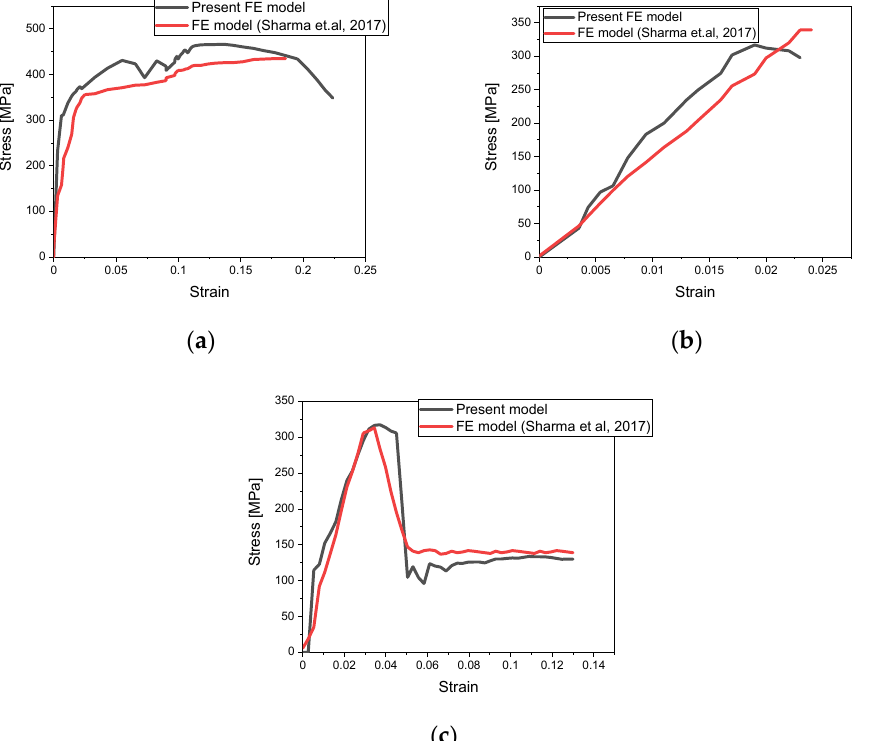
Figure 4. Stress–strain curves of Present FE model and Sharma et al. FE model [20] for ( a ) AL-2024 T3 alloy; ( b ) of [0°/90°/90°/0°] GFRP; ( c ) GLARE 3/2-0.4.